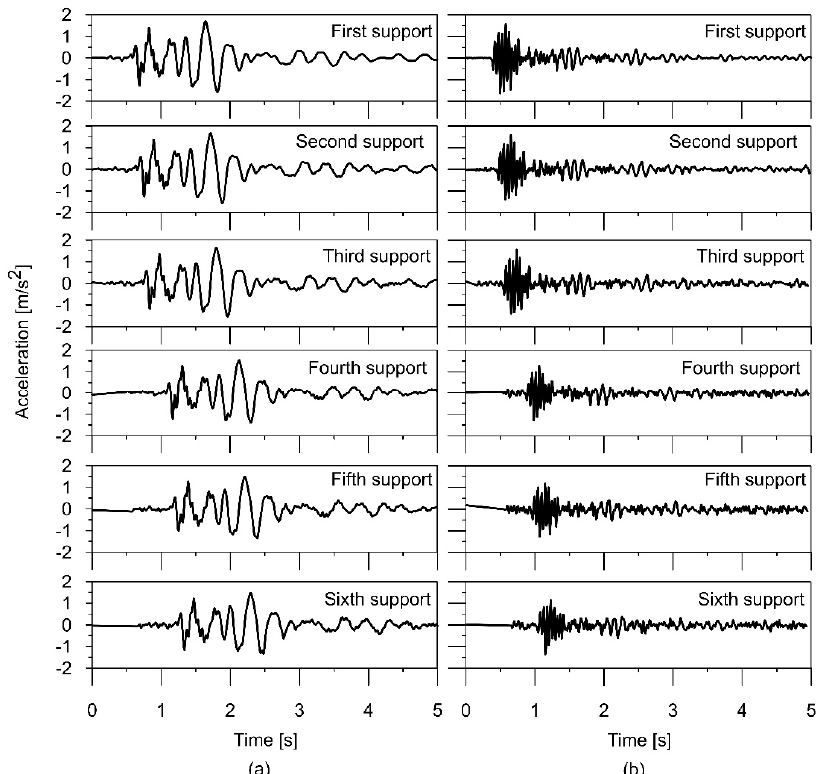
Figure 13. The horizontal (WE) acceleration-time histories of subsequent viaduct supports obtained based on the model of non-uniform mining-induced kinematic excitation for: ( a ) the USCB region; ( b ) the LGCD